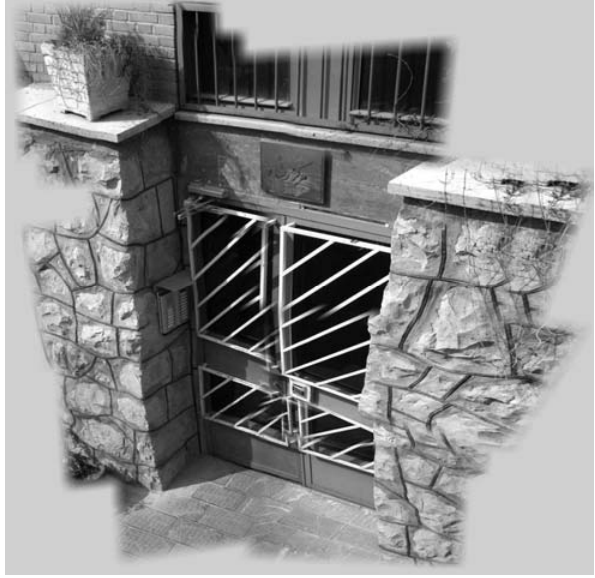
Figure 11. The stitched image in cluster head for the response to 8 th